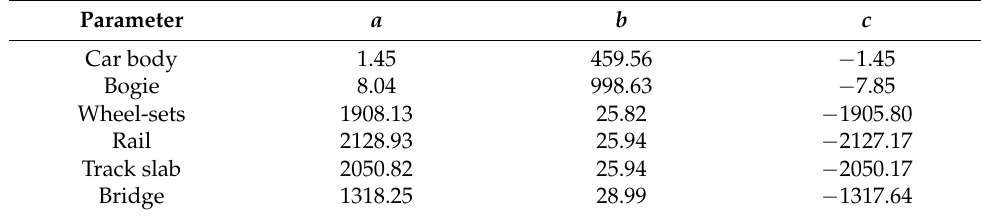
Table 6. The Value of Parameters for the Function under the Track Short Wave Irregularity State.